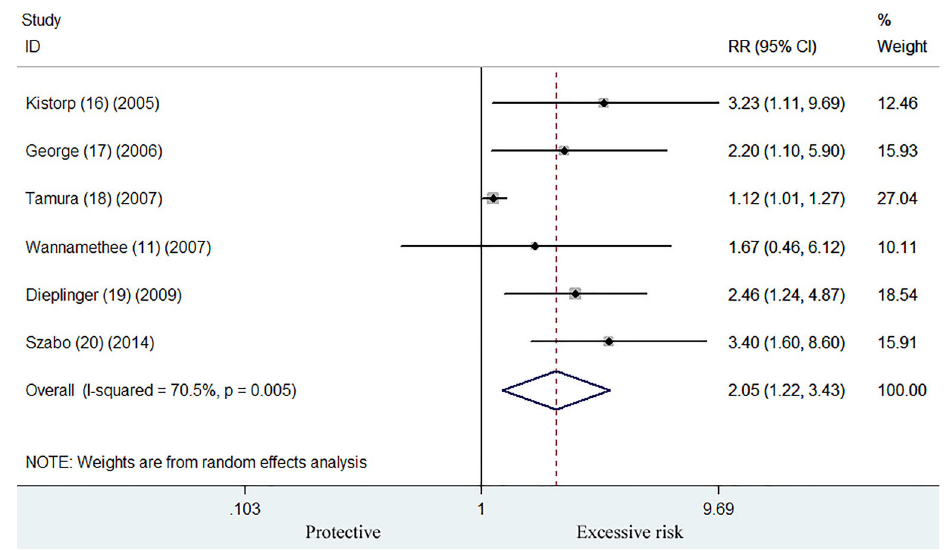
Figure 2. Forest plot showing risk ratio with 95%CI of all-cause mortality for the higher versus lower category of adiponectin level in a random effect model.